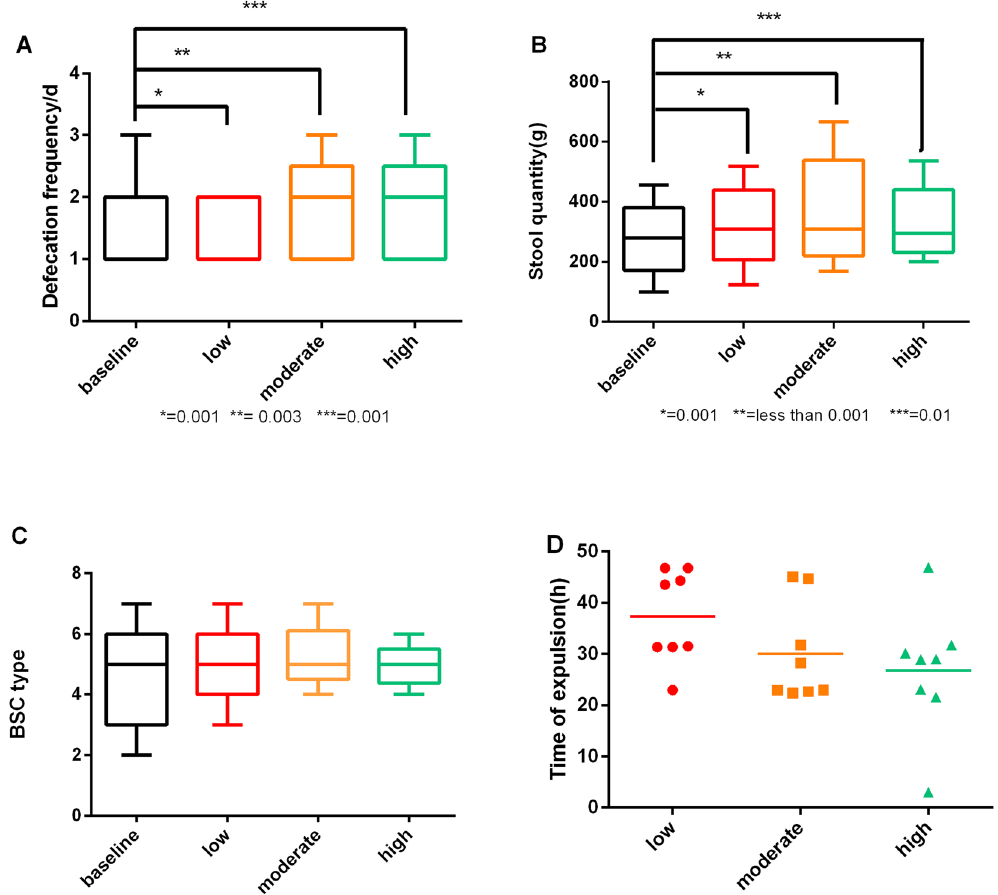
Figure 3. Efficacy study results. ( A ) The median defecation frequency increasing greatly after administration of VCs at different modes compared with that at the baseline. ( B ) VC administration proved to improve stool quantity. Median values were denoted by the central horizontal line within the boxplots containing IQR for the results. ( C ) VC administration did not change the faecal character which showed its safety. ( D ) Mean expulsion time of capsules at different modes depicted by the horizental line showing no significant difference. (dots, square, triangle indicating beagles swallowing low, moderate and high mode VCs,